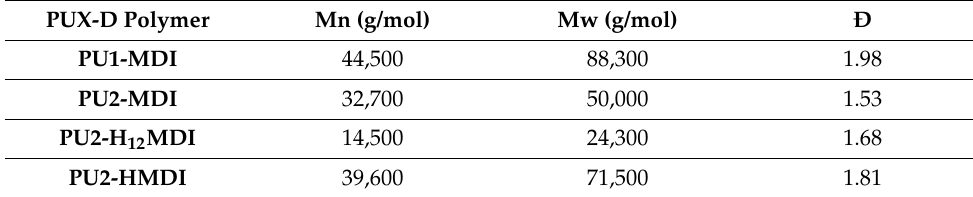
Table 2. Molecular weight and polydispersity index (Ð) of polymers. PUX-D